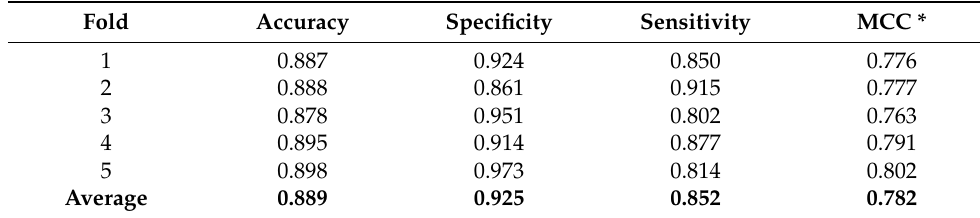
Table 5. Model performance of five-fold